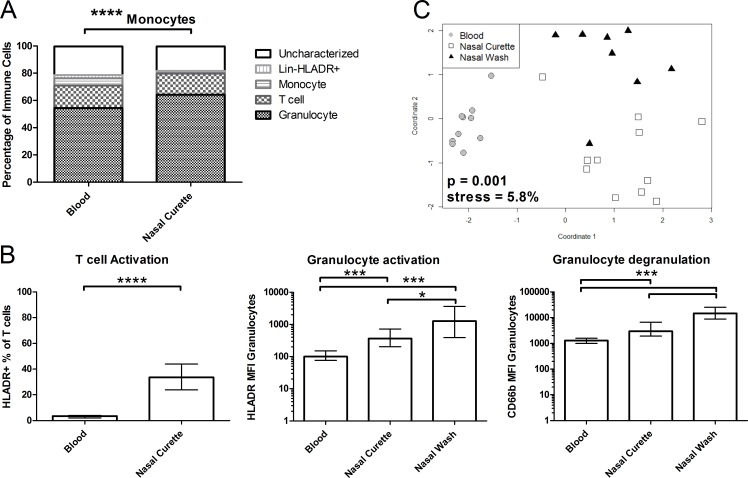
Comparison of samples from nasal mucosa and blood.(A) Median proportions of granulocytes, T cells, monocytes, lineage- HLA-DR+ and uncharacterized cells among immune cells in blood (n = 10) and nasal curette (n = 139). **** p < 0.0001 Mann-Whitney test. (B) The percentage of HLA-DR+ T cells in blood and nasal curette samples and mean fluorescent intensity (MFI) of HLA-DR and CD66b on granulocytes was measured for blood, nasal curette and nasal wash (n = 8) samples. Median and interquartile range are shown. *p < 0.05, ***p < 0.001 Kruskal-Wallis, followed by Dunn’s Multiple Comparison Test. (C) Multi-dimensional scaling analysis shows the clustering of samples from blood (grey circles), nasal curette (open squares, 11 randomly selected) and nasal wash (black triangles). The epithelial cell yield, activation state of granulocytes and composition of the immune cells were taken into account. Kruskal stress = 5.8% and Analysis of Similarity ANOSIM p-value = 0.001.